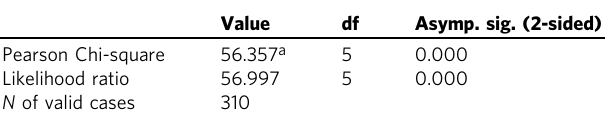
Table 3 Comparisons between genders on farmland access by tenure arrangements.